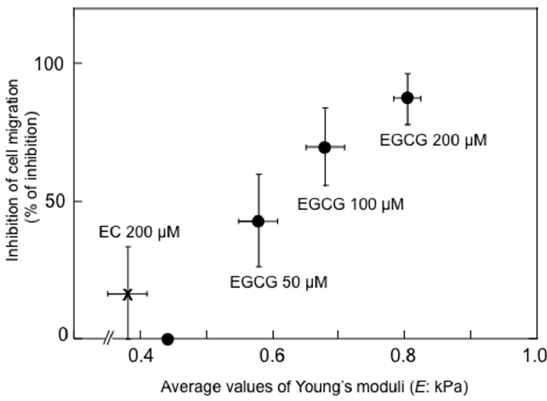
Figure 3. Increase in average values of Young’s moduli and inhibition of cell migration depending on